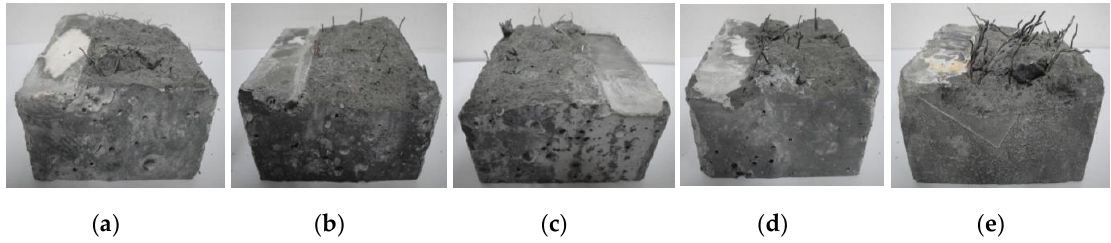
Figure 5. Morphology of steel fibers on the fracture surfaces of specimens after fracture energy testing. ( a ) SF1; ( b ) SF2; ( c ) SF3; ( d ) RSF; ( e ) RSFR.